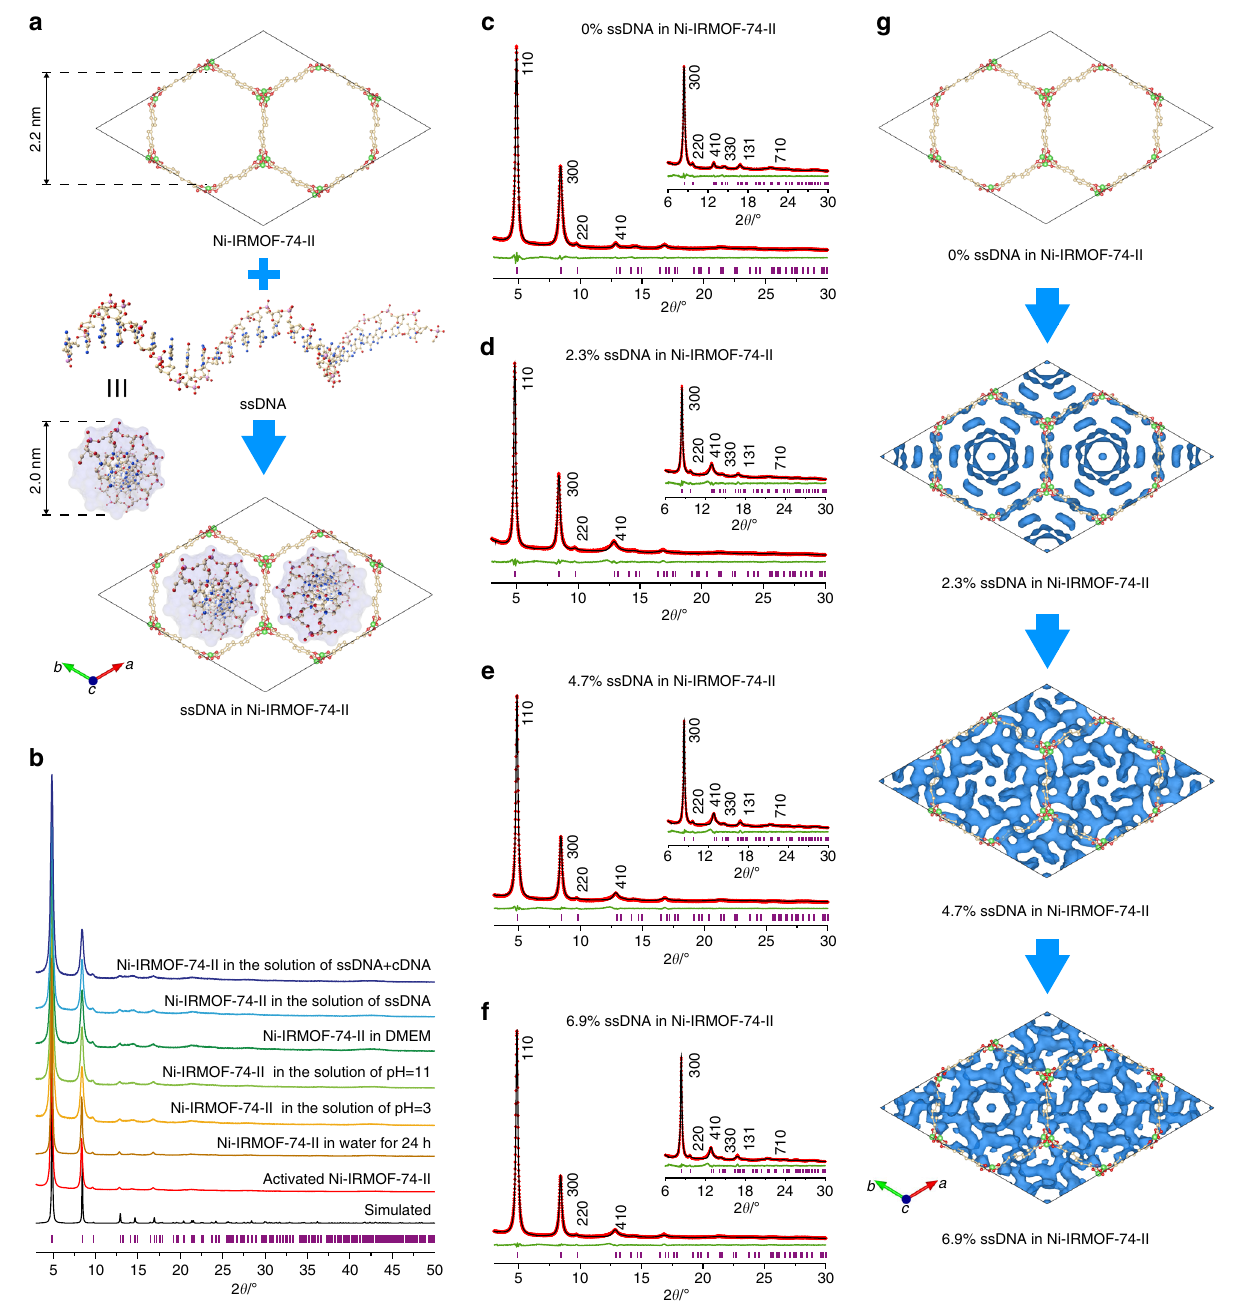
Fig. 2 Visualization of precise ssDNA inclusion in the pore of Ni-IRMOF-74-II. a Excellent match between the size of ssDNA and that of Ni-IRMOF-74-II pores leads to inclusion of ssDNA with atomic accuracy. b PXRD patterns of Ni-IRMOF-74-II samples tested in various aqueous solutions. Wavelength of X-ray sources, λ = 1.5406 Å. c – f PXRD patterns of MOF samples loaded with different amounts of ssDNA in weight percent (0%, 2.3%, 4.7%, and 6.9%, respectively). Wavelength of X-ray sources, λ = 1.5406 Å. The experimental (red), re fi ned (black), and difference (green) patterns are displayed. The Bragg positions are marked as pink bars. g Electron distribution map of ssDNA in Ni-IRMOF-74. Carbon (gold), nitrogen (blue), oxygen (red), and phosphorous